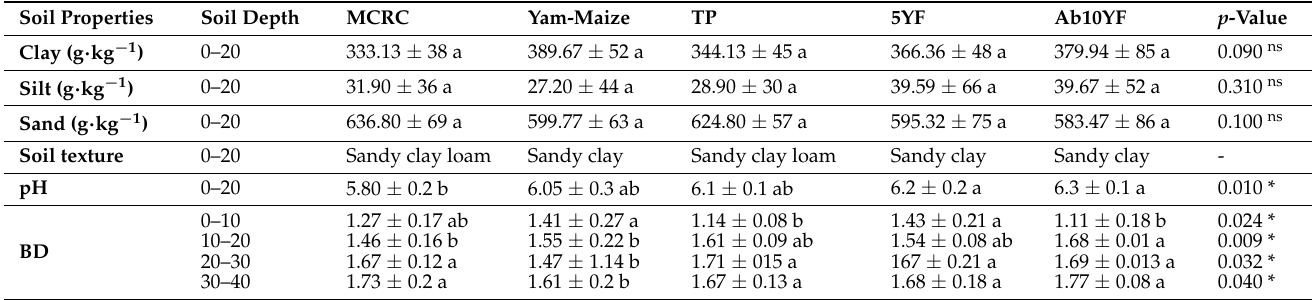
Table 2. Soil properties under the different cropping